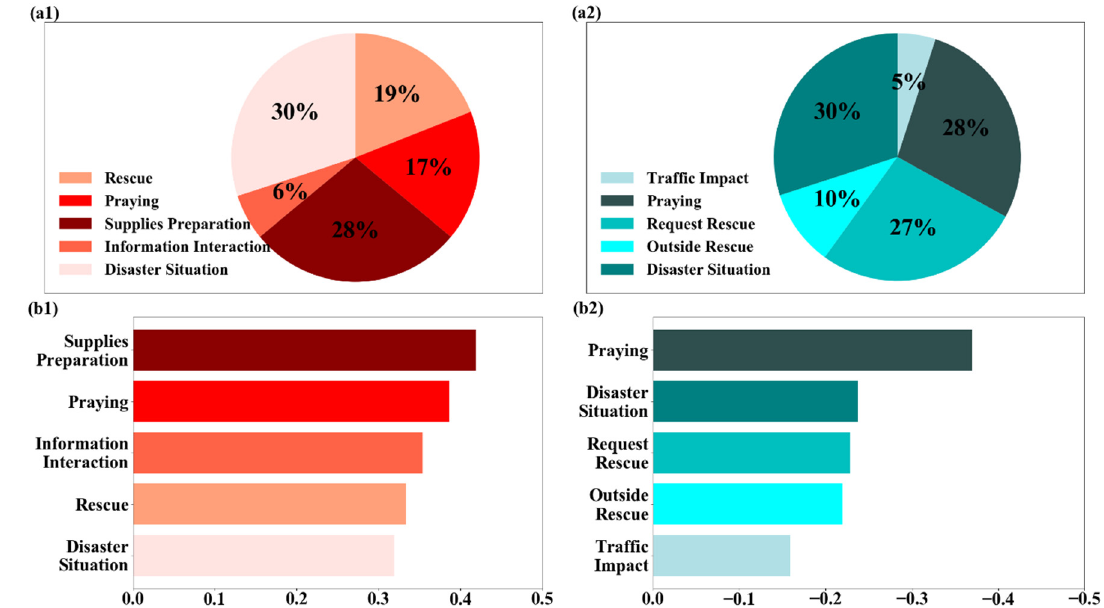
Figure 6. The proportion of topics and sentiment ranking in positive and negative tweets ( a1 ) Topics of positive tweets ( a2 ) Topics of negative tweets ( b1 ) The sentiment ranking of positive tweet topics ( b2 ) The sentiment ranking of negative tweet topics.